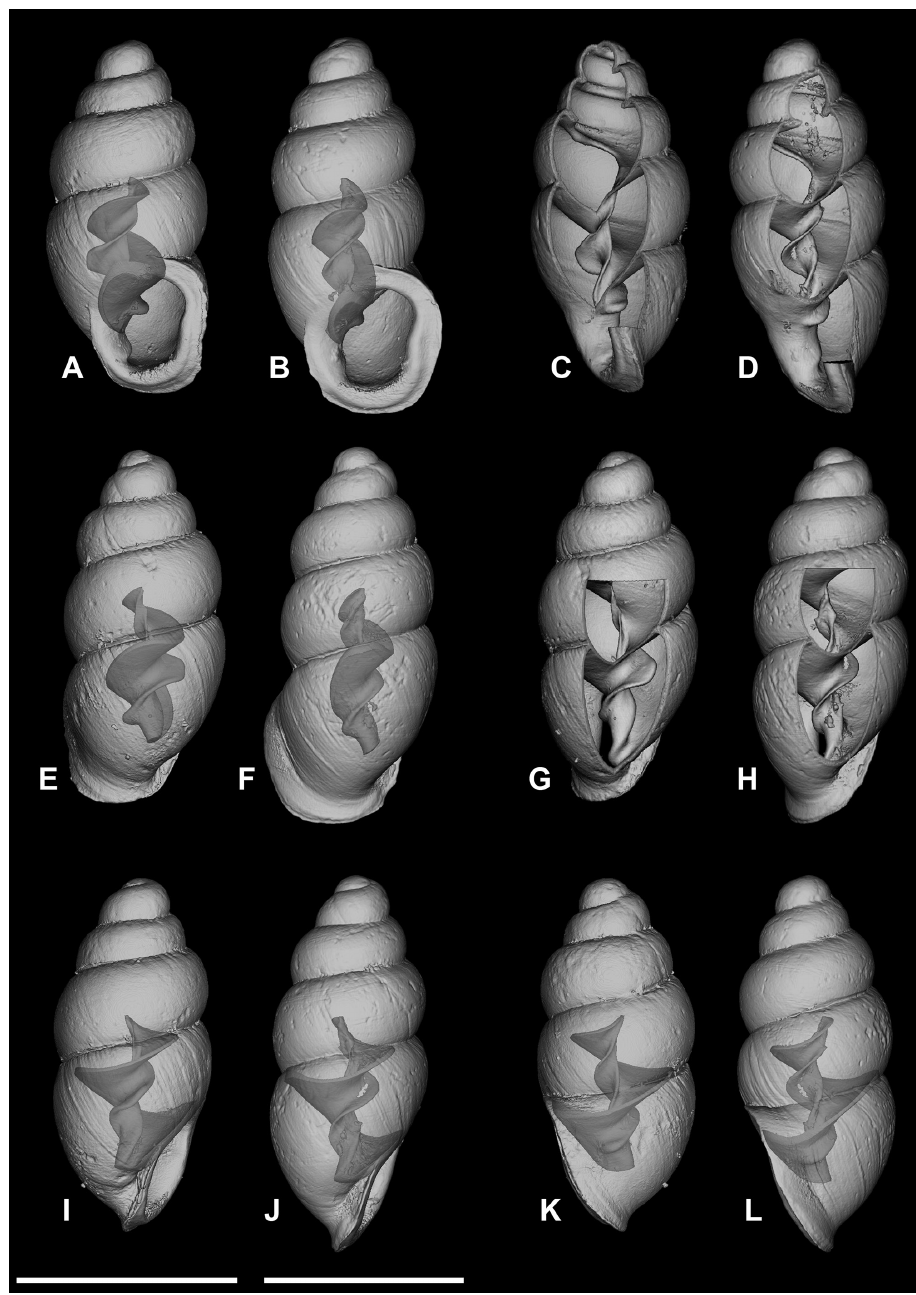
Figure 9. Comparative material, Carychium mexicanum Pilsbry, 1891 (AJC 2092) from Puebla, Mexico A, C, E, G, I, K and topotypic C. costaricanum E. von Martens, 1898 (AJC 2093) B, D, F, H, J, L ; A–L CT scans showing columellar apparatus and configuration of the columellar lamella in both species A–L . Scale bar 1